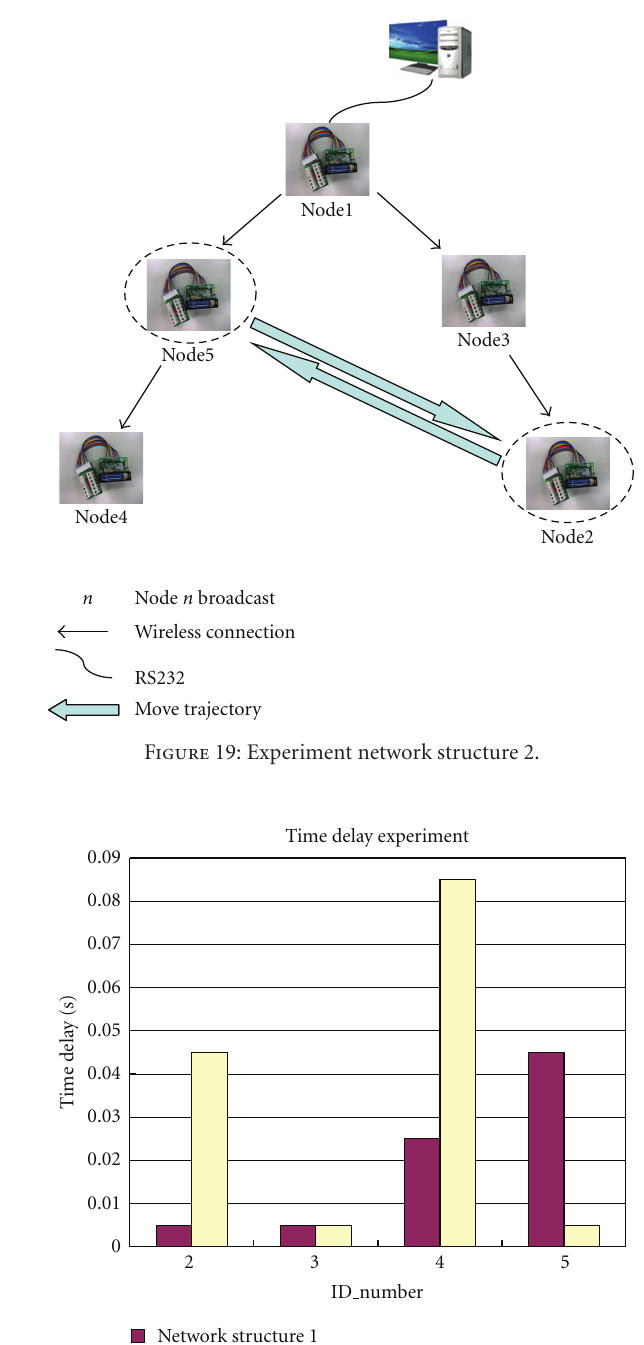
Because after node1 broadcasted the data, node2, node3 and node4 start to broadcast one by one. So the data from node1 can be sent to node5 in one broadcast cycle. Before the middle nodes (such as node 2, node 3 and node 4) broadcast DSF, they also input their sharing data to the DSF, therefore, each node can get previous nodes’ data. So node5 can obtain all the nodes’ sharing data. And then the data from